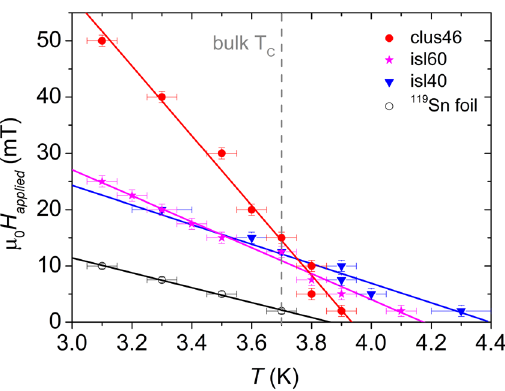
Figure 3. The boundaries of the superconducting phase for the different nanostructures extracted from magnetometry data shown together with the phase boundary of the 119 Sn foil. The solid lines are linear fits to the measured data points.